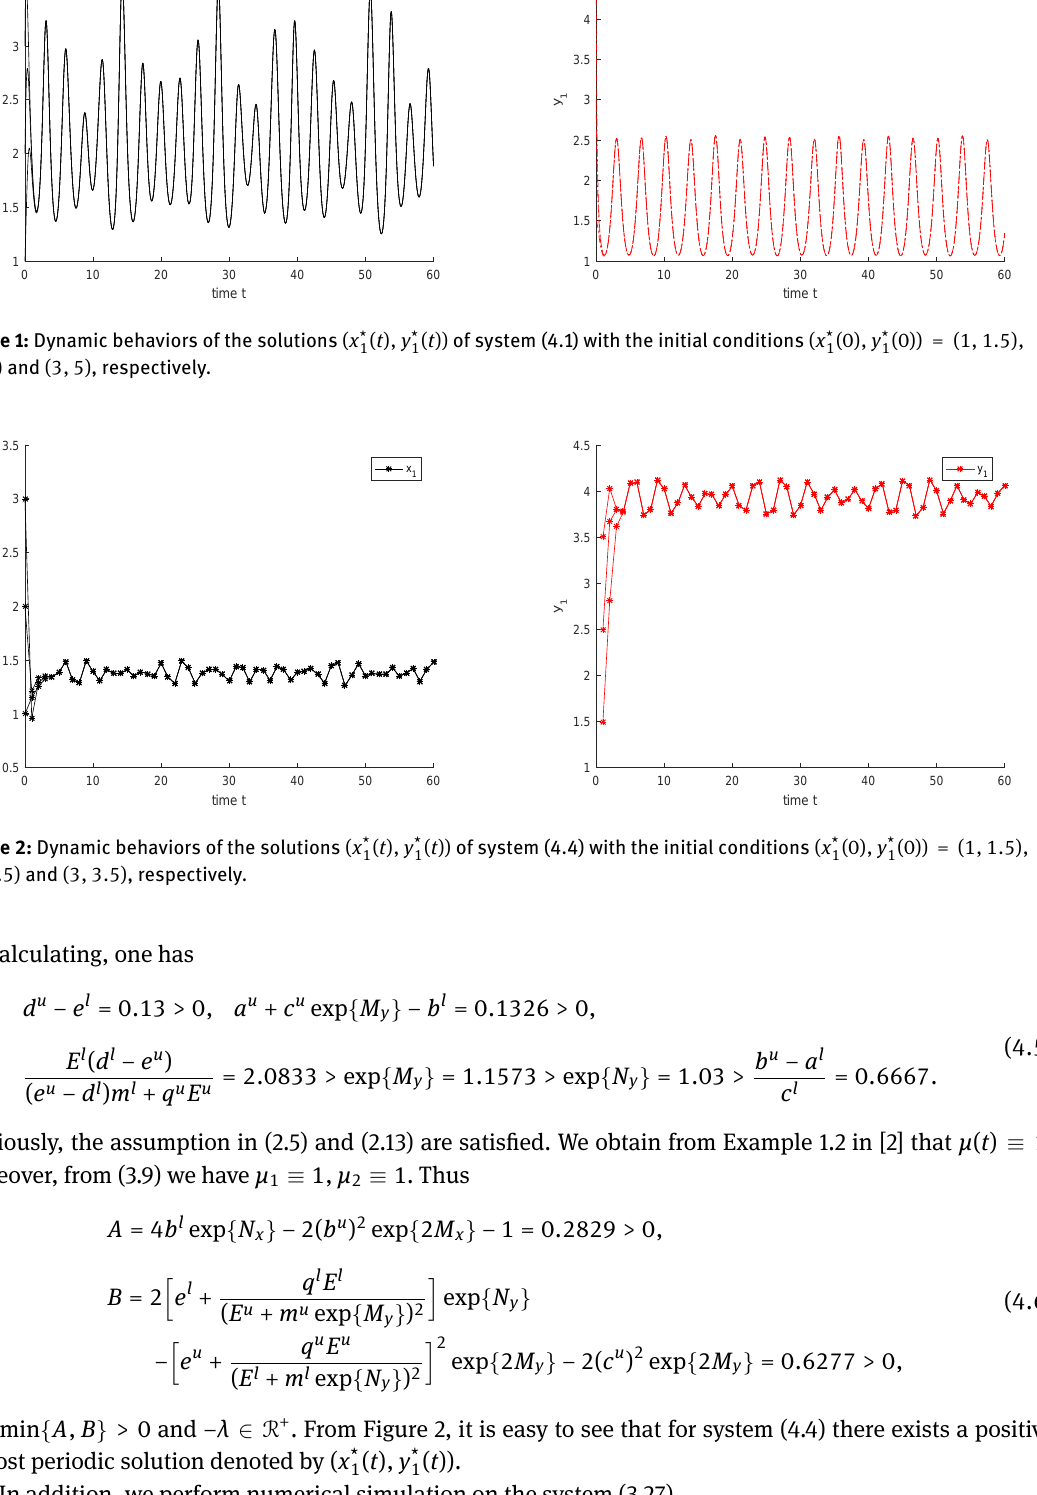
( t )) of system (4.1) with the initial conditions ( x * ( t ), y * 1 1